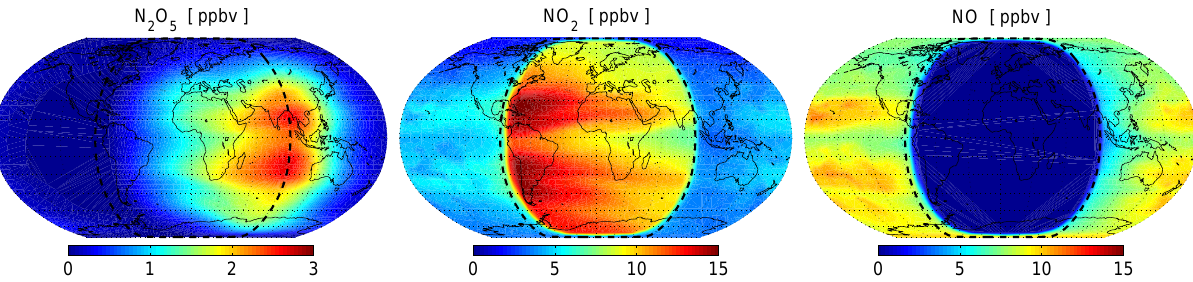
Figure 14. Snapshot of N 2 O 5 , NO 2 and NO as simulated by WACCM at 5hPa, 21 March, 00:00UT. The solar zenith angle of 90 ◦ (dashed black lines) approximately marks the solar terminator. The nightside is at the centre of the maps. The reservoir N 2 O 5 is assembled during night-time by Reaction (R12) until it peaks at the solar terminator. During daytime N 2 O 5 is dissociated into NO 2 and NO 3 by Reactions (R14) and (R13). NO 2 in turn is photodissociated into NO and O or reacts with O by Reactions (R9) and (R10). Both reactions provide reactive NO which plays a major role in the daily ozone cycle at